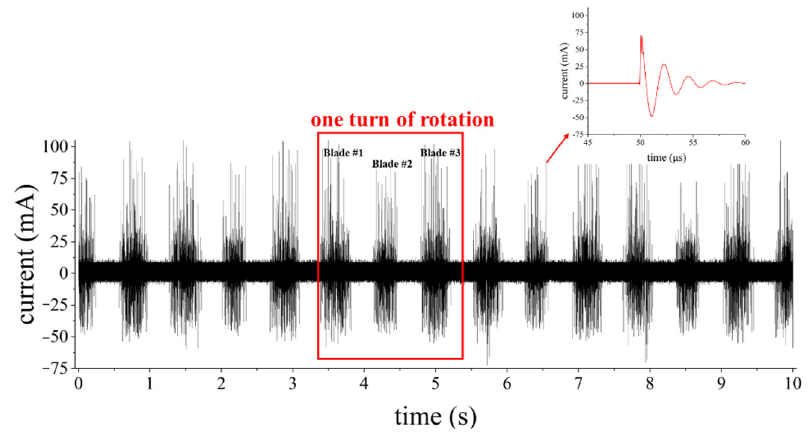
Figure 4. Measurement results of the corona current at the blade tip of rotating wind turbine.